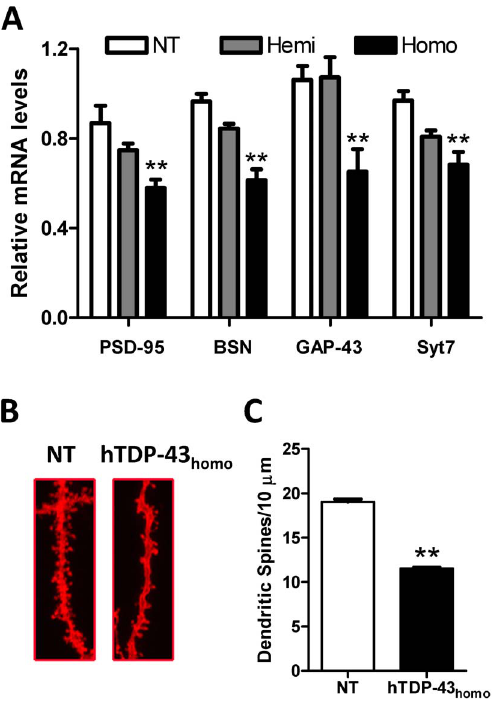
Figure 5. Alternation of RNA levels of synaptic proteins and dendritic spines in hTDP-43 WT homozygous mice. ( A ) Compared with non-transgenic (NT) mice, the RNA levels of TDP-43 targets PSD-95, Bsn, GAP-43 and Syt7 are significantly decreased in TDP-43 homozy- gous mice, but not in TDP-43 hemizygous mice. ( B–C ) The numbers of dendritic spine are dramatically reduced in the brain of TDP-43 hemozygous mice compared to NT mice. Data shown are the means 6 SEM of 3–5 mice per group; **p , 0.001, as assessed by one-way ANOVA with Tukey’s posthoc analysis or Two-tailed student’s t test to compare measures among 2